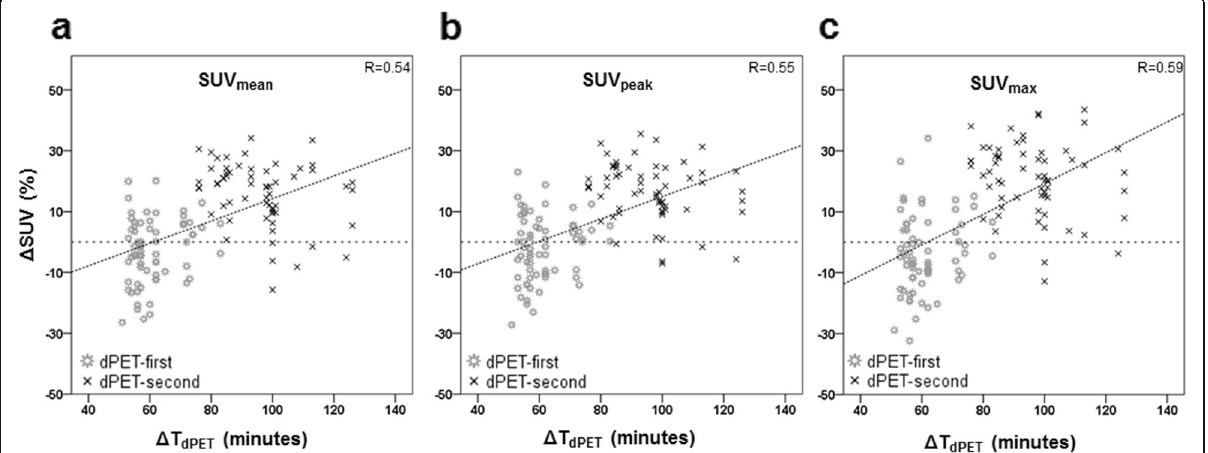
Fig. 3 Scatterplot comparing the relative change in SUV mean ( a ), SUV peak ( b ) and SUV max ( c ) with Δ TdPET, defined as the time between FDG- administration and start of the dPET scan. Δ SUV mean , Δ SUV peak and Δ SUV max increased with prolonged Δ T dPET ( p <